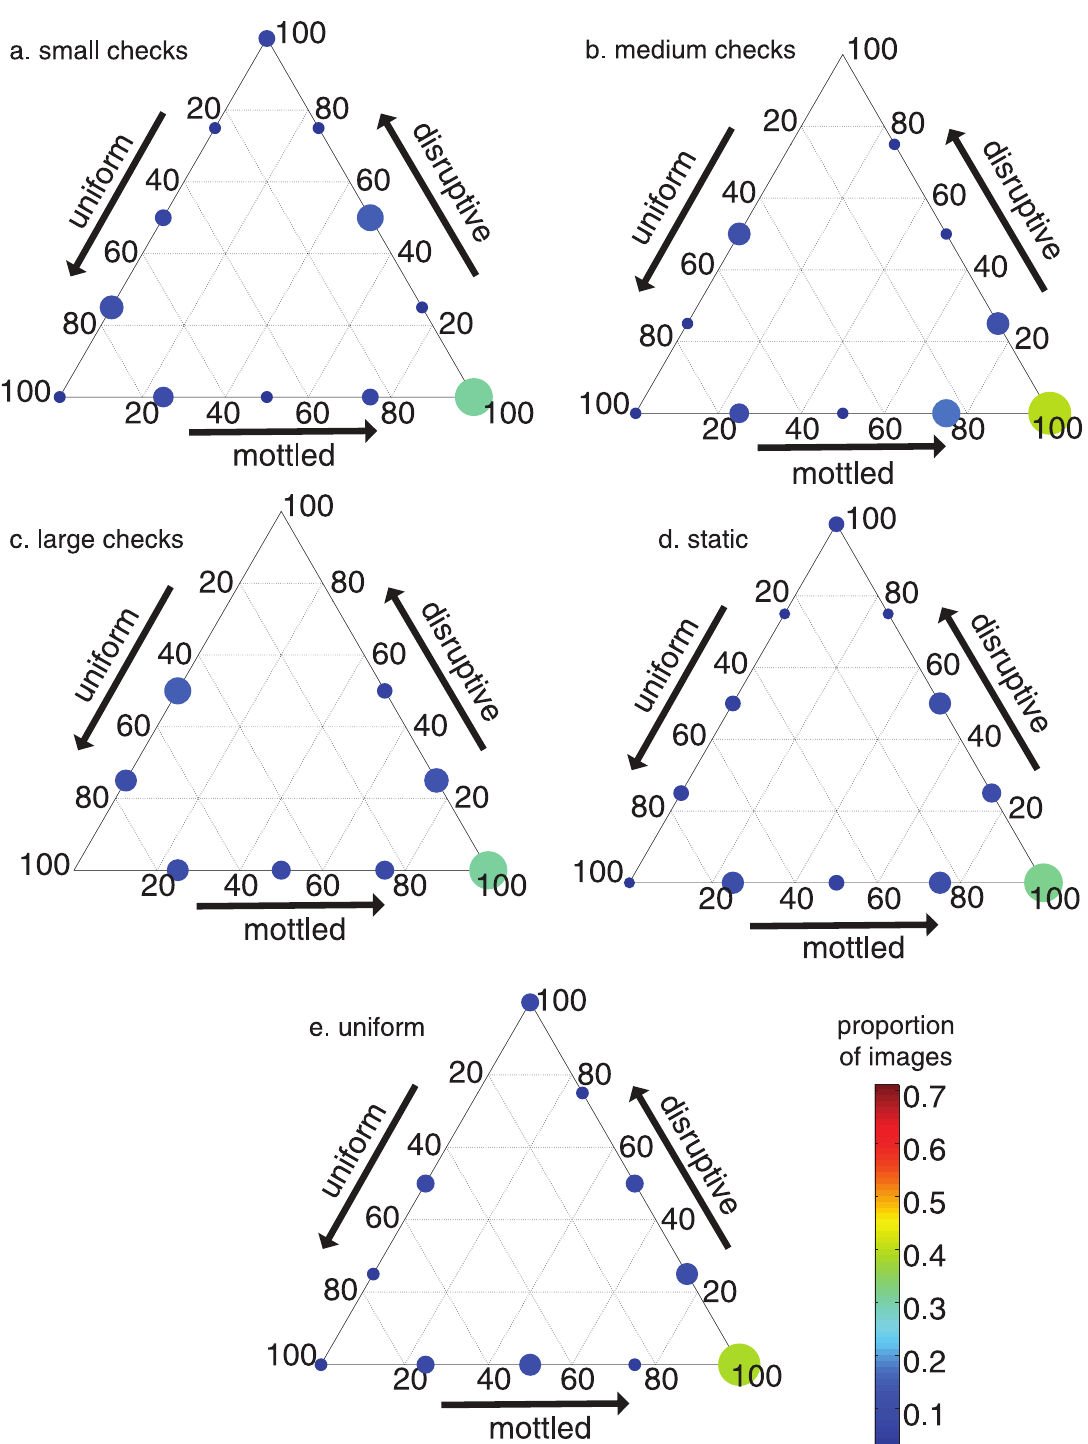
Fig 6. The classification of responses of cuttlefish exposed to different side stimuli. See text and Fig 4 for an explanation on how to read ternary plots. The larger the dot and warmer the color, the greater proportion of responses in that camouflage category. Proportion of cuttlefish responses to a vertical stimulus of (a) small checkerboard, (b) medium checkerboard, (c) large checkerboard, (d) television static pattern, and (e) uniform color.